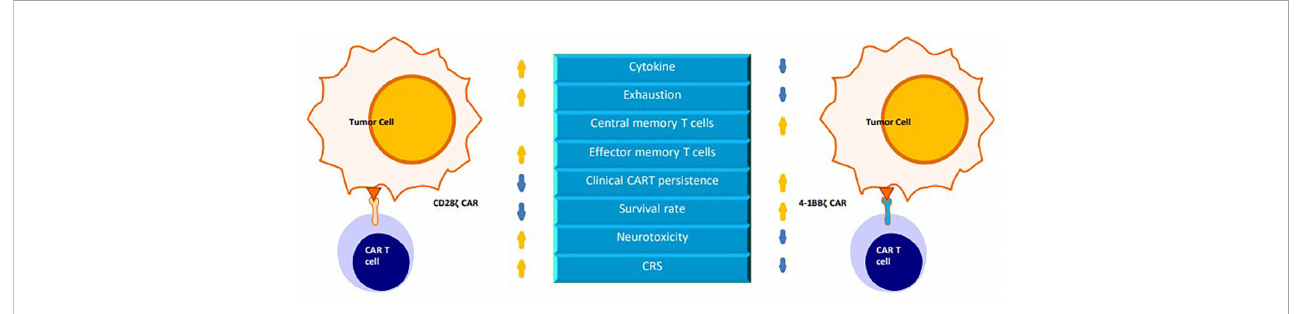
FIGURE 2 A comparison of chimeric antigen receptors containing CD28 versus 4-1BB costimulatory